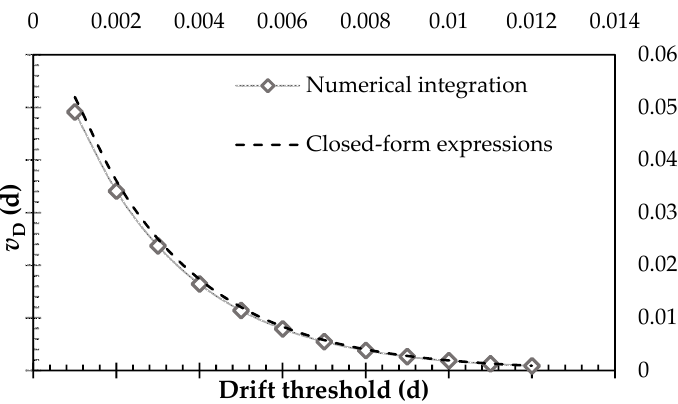
Figure 9. Demand hazard curves. Table 6. Reliability